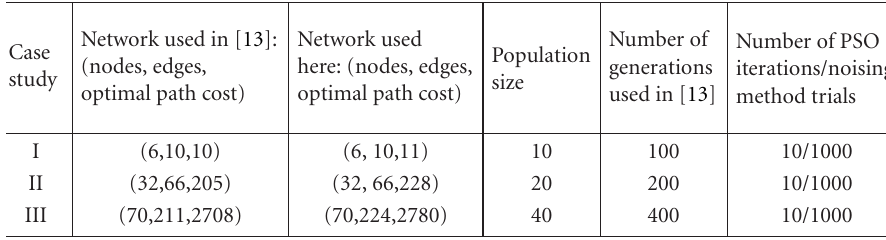
Table 4 . 3 . Di ff erent testing conditions for test number